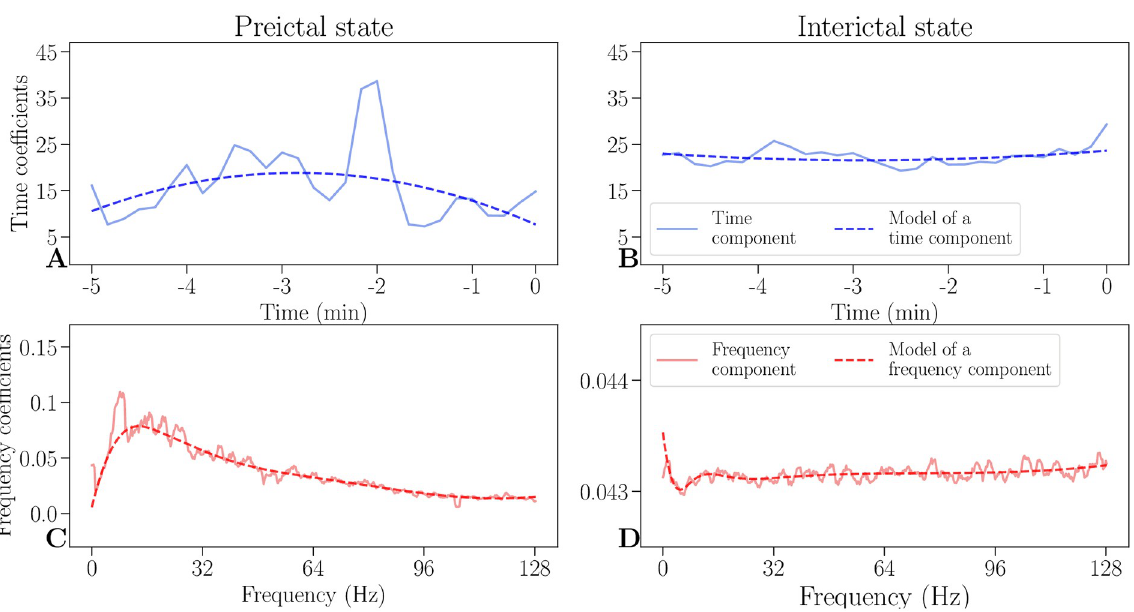
Fig 2. Time and frequency components and its models. An example of decomposed time (solid blue lines) and frequency components (solid red lines) and their respective models (dashed lines) of a preictal state ( A , C ), as well as an interictal state ( B , D ). In a preictal state, the time component ( A ) increases as a seizure is approaching, while the frequency component ( C ) has an increase in low frequencies. Both interictal components ( B , D ) are steady and are an order of magnitude lower than their respective preictal components ( A , C